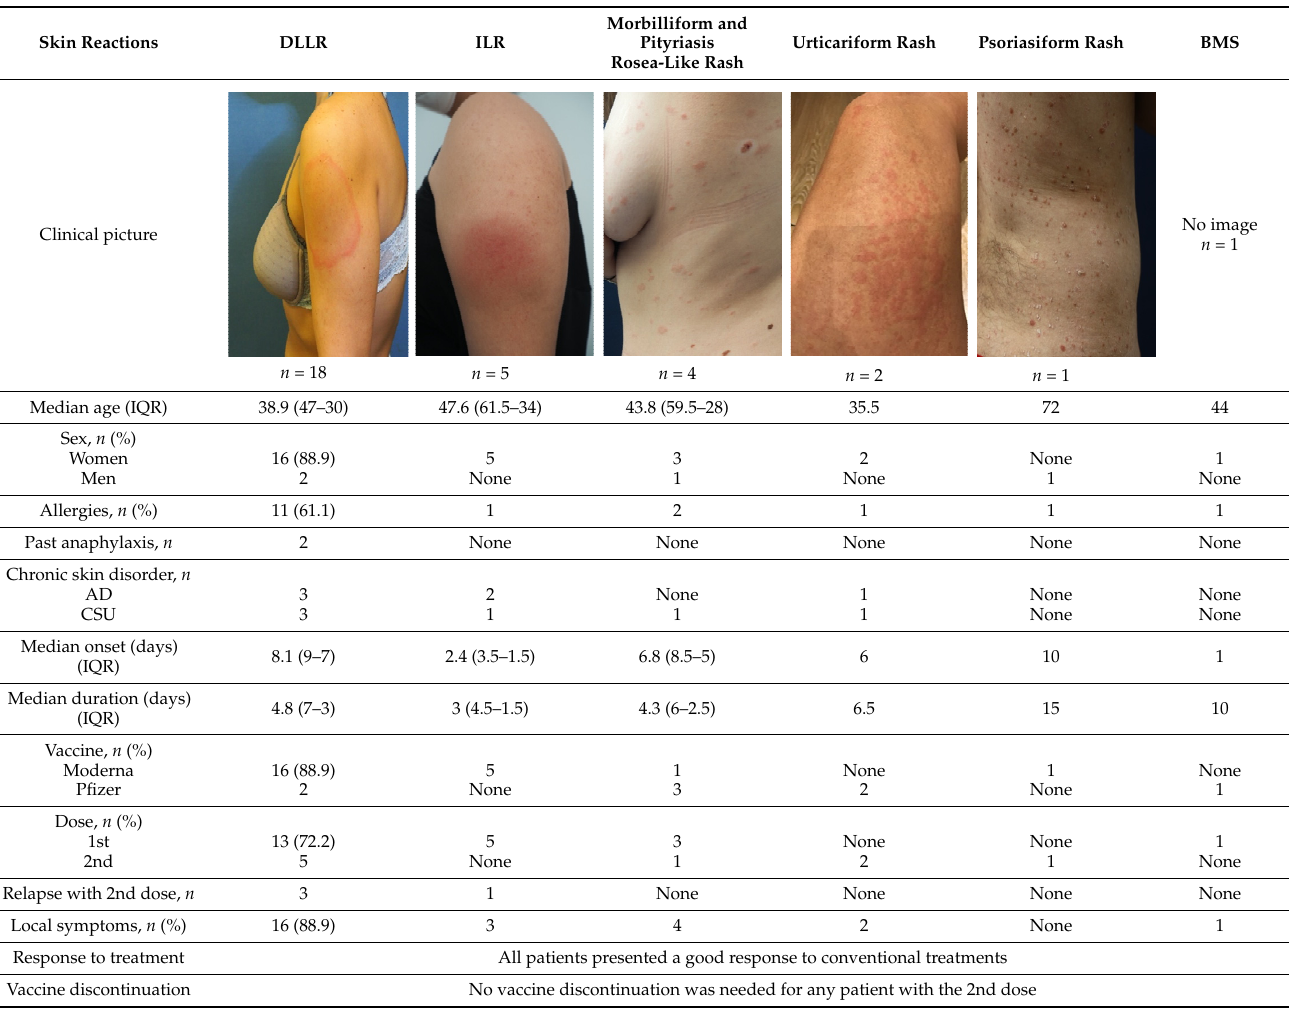
Table 1. Demographic baseline and clinical characterization of skin reactions due to mRNA COVID-19 vaccines.